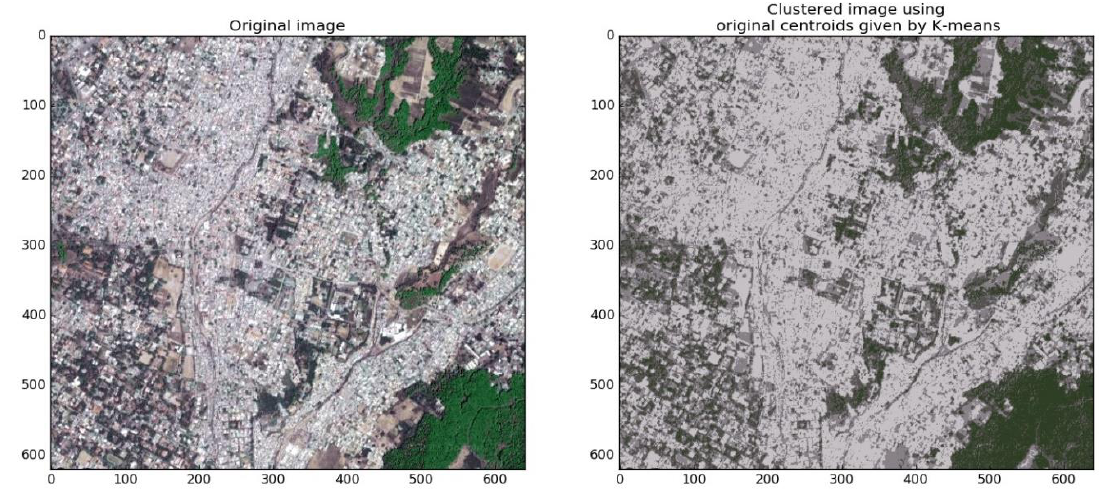
Figure. 4. Comparison between the original image and clustered image using original centre